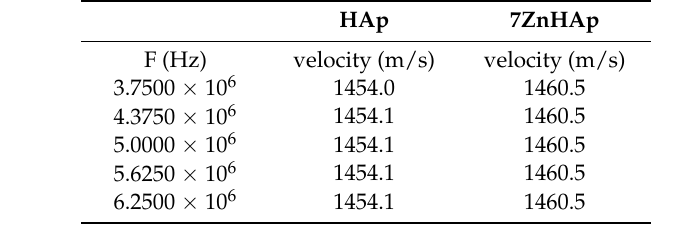
Table 2. The velocity values in biphasic medium versus frequencies for HAp and 7ZnHAp dispersions